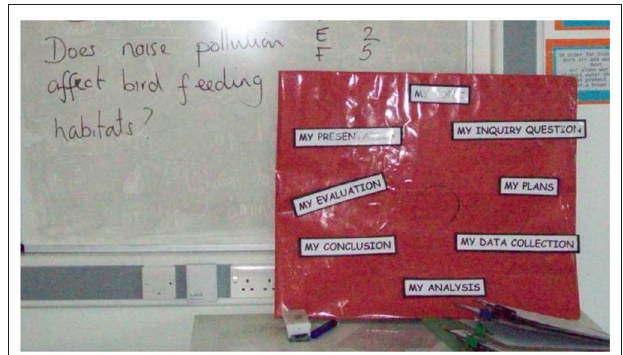
FIGURE 7 | The poster for inquiry learning presented in the Nottingham class in 2009.